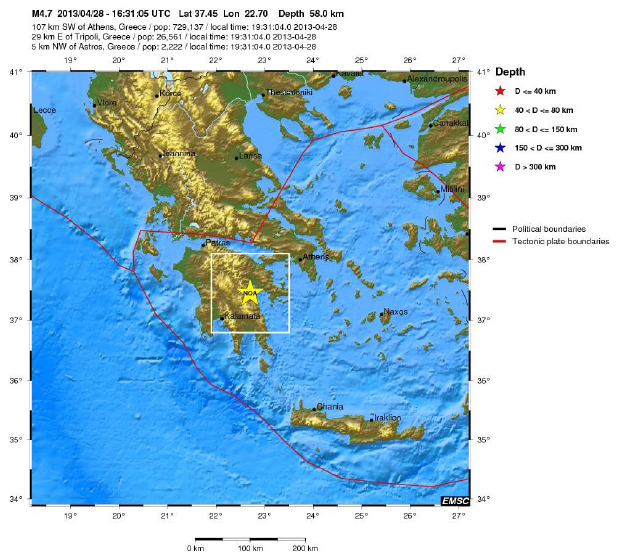
Figure 9. The time window of 25s for the above recording (left) with the HVSR result (right). Different colours corresponding in different time windows. Grey background colour presents the auto- matic recognition of fundamental frequency of the Geopsy program.